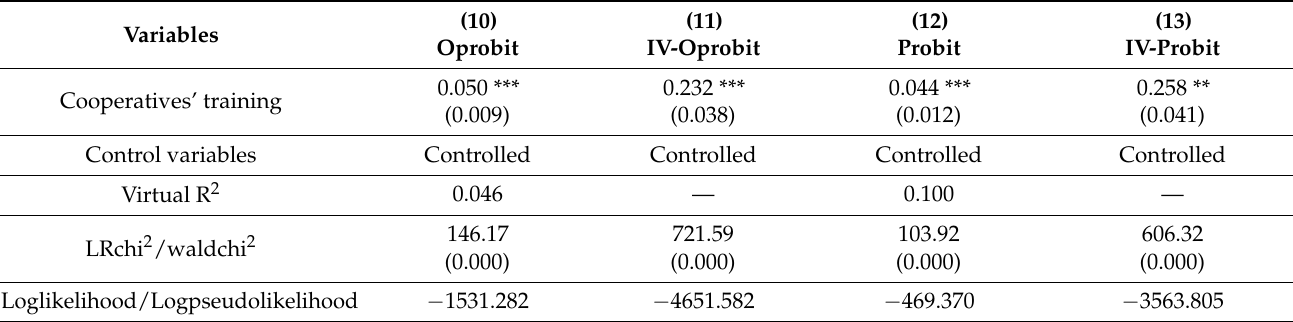
Table 7. Robustness test